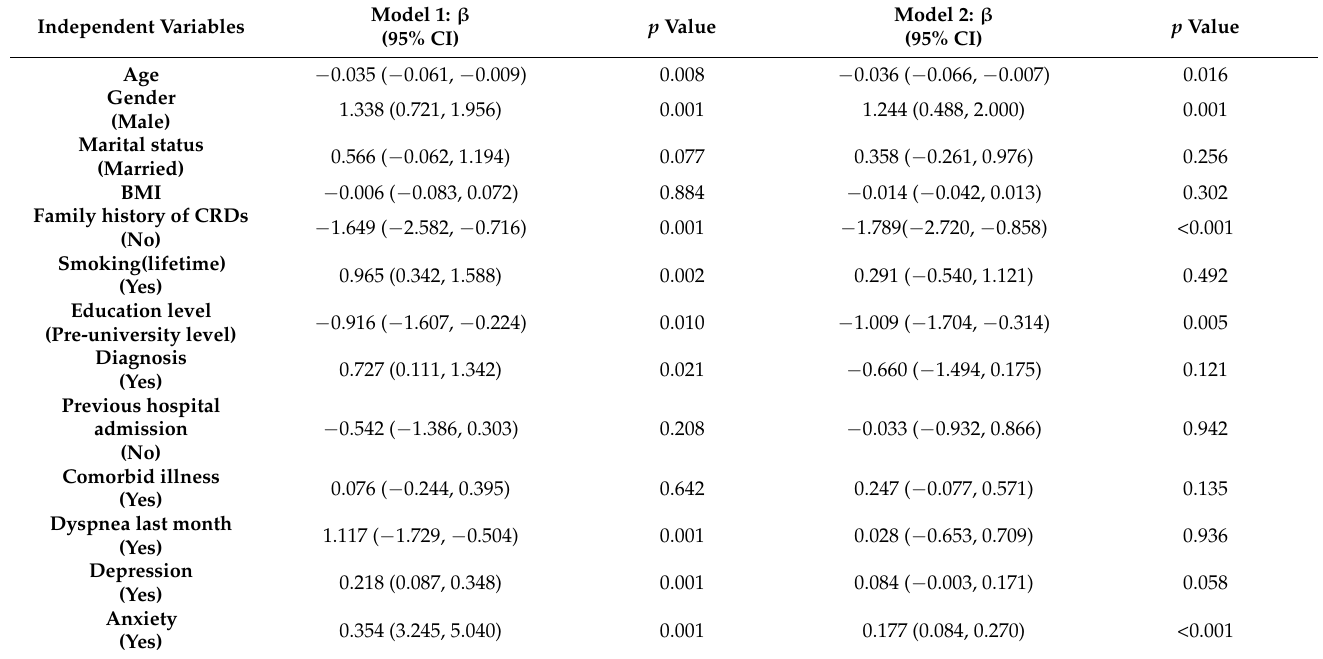
Table 4. Regression analyses of poor sleep quality based on the characteristics of patients with chronic respiratory diseases (N =